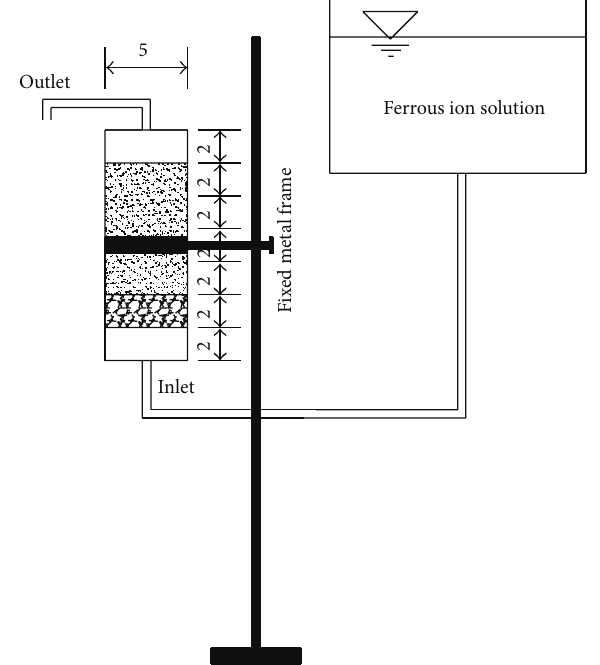
Figure 5: Chemical clogging experimental setup (distance numbers are all in